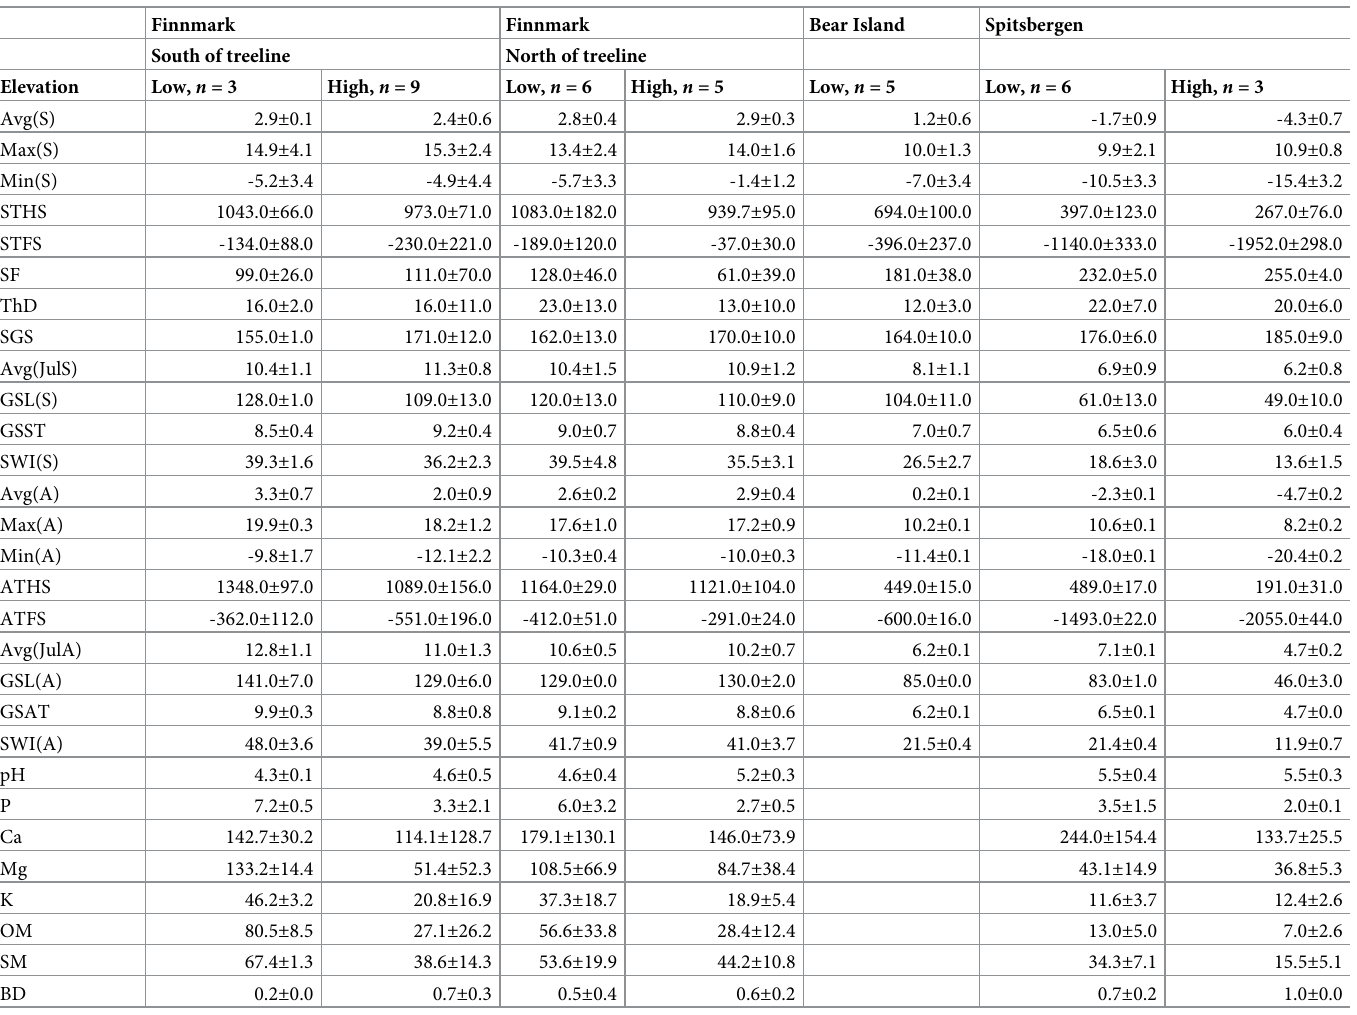
Table 3. Average air (A) and soil (S) temperature variables and soil properties from the different study areas.